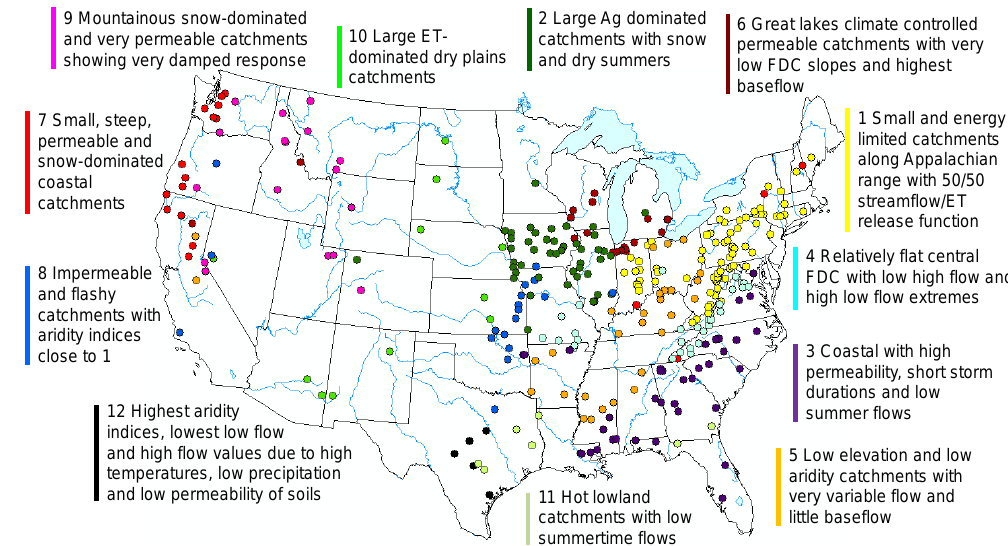
Fig. 1. Results of cluster analysis based on 6 hydrological